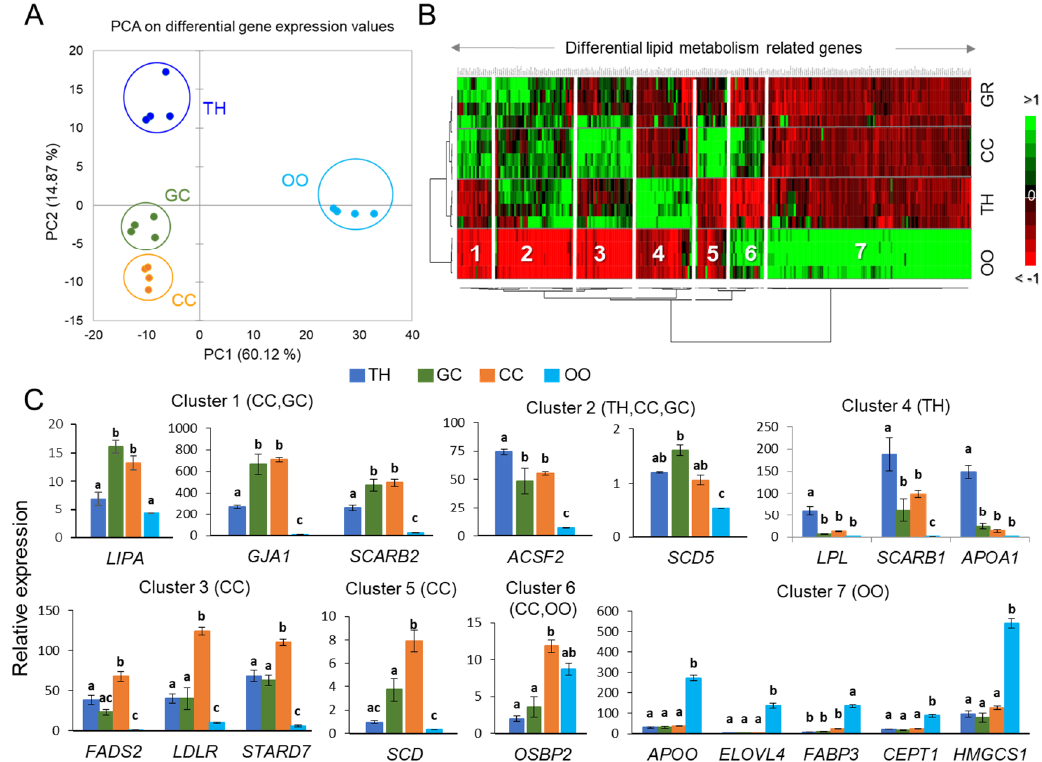
Figure 7. Differential analysis of gene expression in bovine theca (TH), granulosa cells (GC), cumulus cells (CC), and oocytes (OO), using microarray hybridization ( n = 4 per each cell type). ( A ) Discrimination of ovarian follicular compartments by expression profiles of lipid metabolism-related genes, using principal component analysis. ( B ). Heat map representation of differentially expressed genes ( p < 0.05, Benjamini–Hochberg correction) related to lipid metabolism. ( C ) Examples of differentially expressed genes between ovarian follicular compartments. Bars are the mean values of four independent replicates +/ − SEM. Different letters mean significant difference at p < 0.05 (ANOVA, Tukey test for multiple comparisons). LIPA —Lipase A; GJA1— Gap